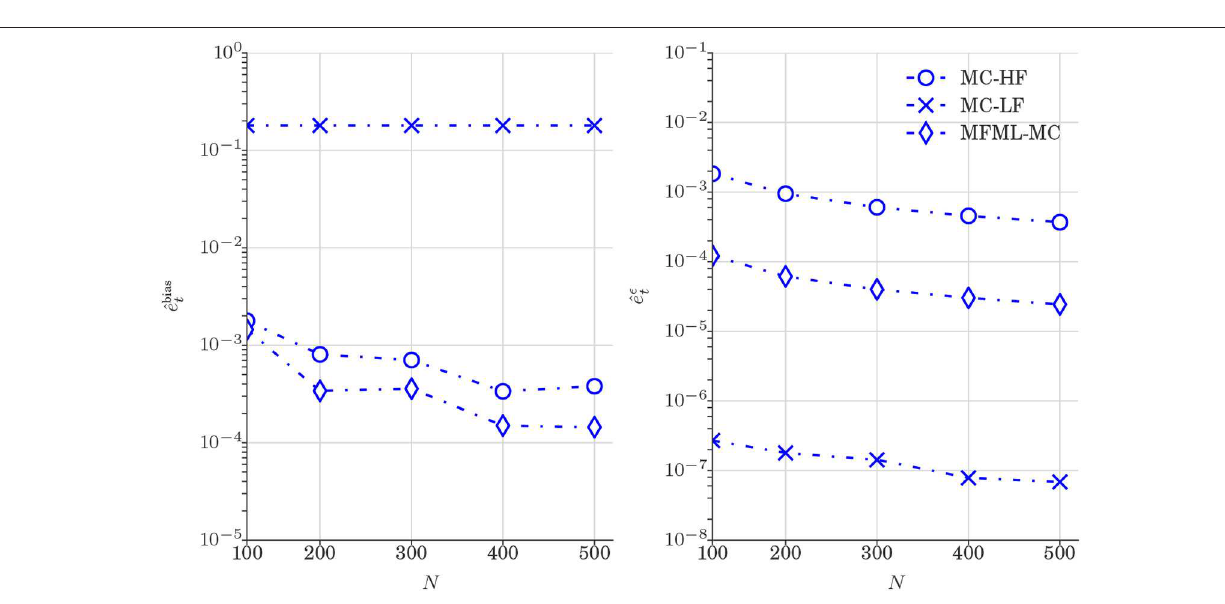
100, where p is the = 0.8 PVI. =